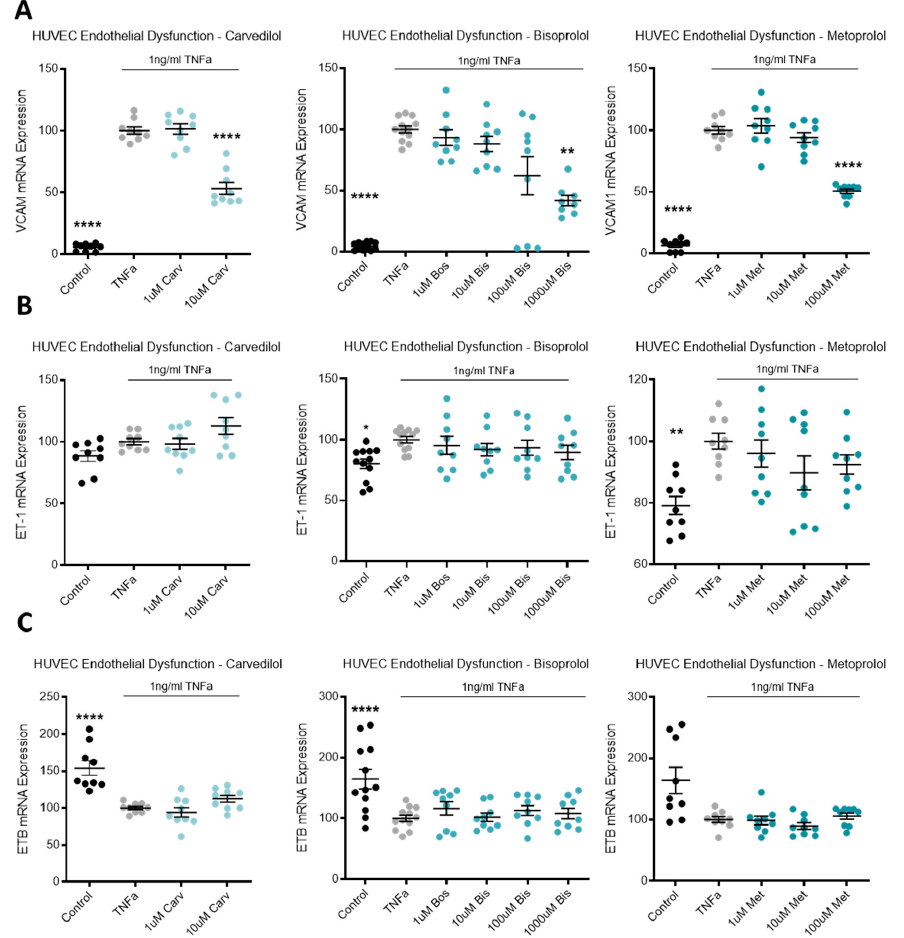
Figure 6. In a model of endothelial dysfunction, VCAM mRNA expression is decreased with beta-blocker treatment. In HUVECs treated with TNF α to induce endothelial dysfunction ( A ), VCAM mRNA is significantly reduced with top dose beta-blockers, carvedilol (Carv), bisoprolol (Bis), and metoprolol (Met). In the same model, ET-1 mRNA ( B ) and ETB mRNA ( C ) expression are not affected by Carv, Bis, or Met. Data are mean ± SEM, expressed as a percentage of TNF α control, n = 3–4, * p < 0.05, ** p < 0.01, **** p <